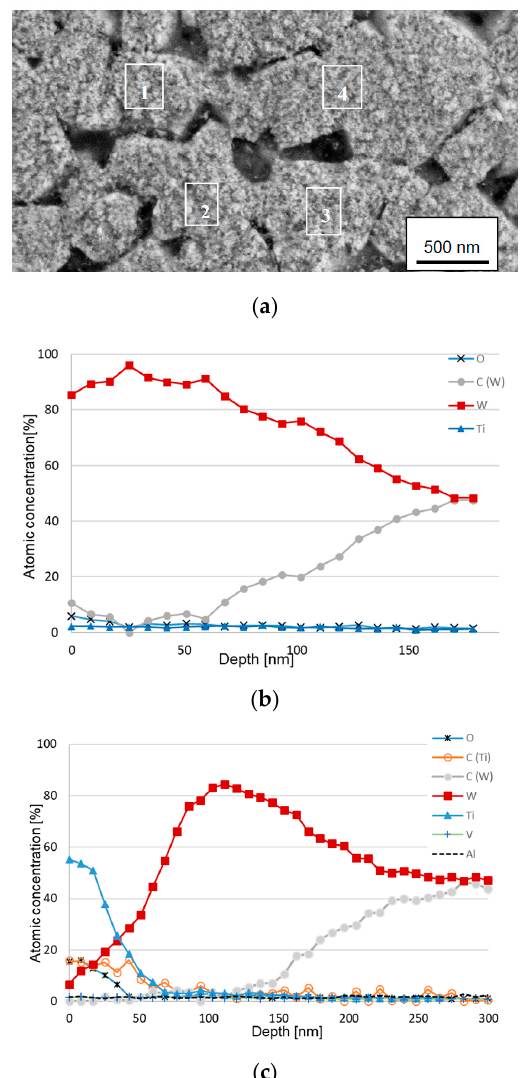
Figure 9. ( a ) SEM image of an area in the center of the worn crater after wet etching (cutting speed: 90 m/min). ( b ) AES depth profile obtained from areas 1, 2 and 3. ( c ) AES depth profile obtained from area 4.